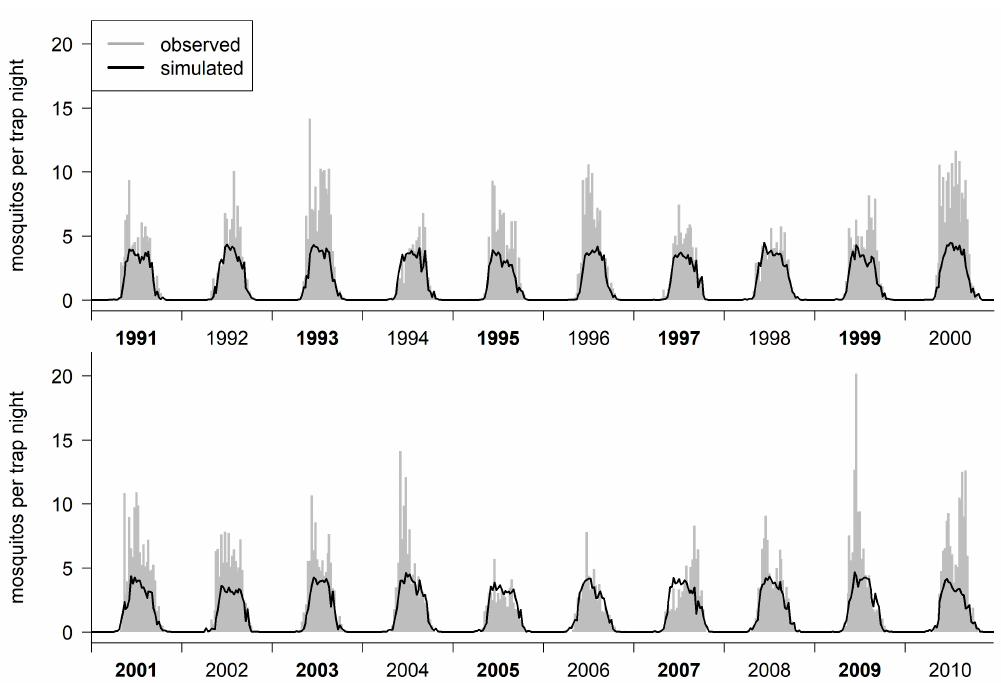
Figure 3. The estimated abundances of active mosquitoes, using the capture data from the test data set, without including precipitation.